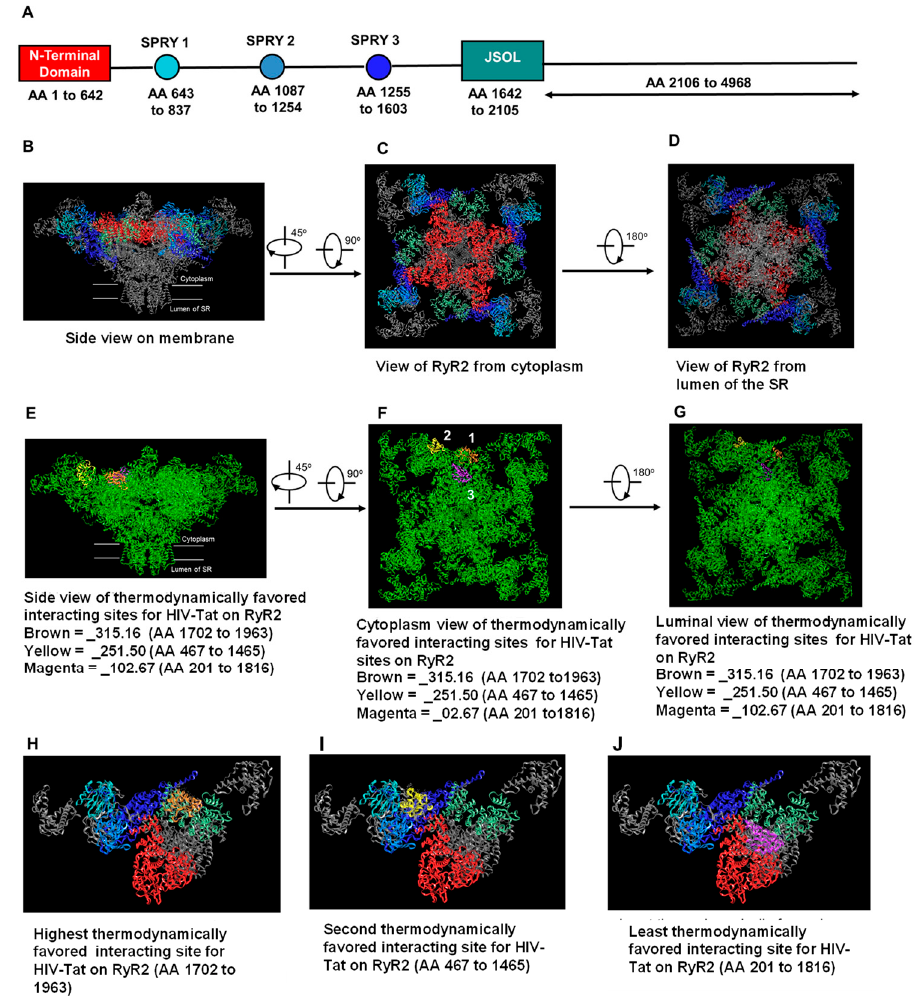
Figure 9. Locations of the thermodynamically favored interaction sites for HIV-Tat on RyR2. Panel A shows the overall structure of the closed (with the N-terminal) domain: SPRY1, SPRY2, and SPRY 3, and the JSOL domain. Panels B – D show the tetrameric structure of RyR2 at 4.2 Å resolution, which is domain-colored with the same scheme as in ( A ), with a view from the membrane, from the cytoplasm, and a view from the lumen of the SR, respectively. Panels E – G show the three thermodynamically favored docking sites for HIV-Tat on RyR2, with a view from membrane, from the cytoplasm, and a view from the lumen of the SR, respectively. The numbers in Panel F refer to the highest (1) to lowest (3) thermodynamically favored sites. Panels H – J show the three thermodynamically favored docking sites for HIV-Tat on a RyR2 monomer in relation to the N-terminal domain: SPRY1, SPRY2, and SPRY 3, and the JSOL domain, which are color-coded to that within Figure 9A. Table 2. Thermodynamically favored Interactions between RyR2 and HIV-Tat at site 2. Table 1. Thermodynamically favored interactions between RyR2 and HIV-Tat at site 1. RyR2